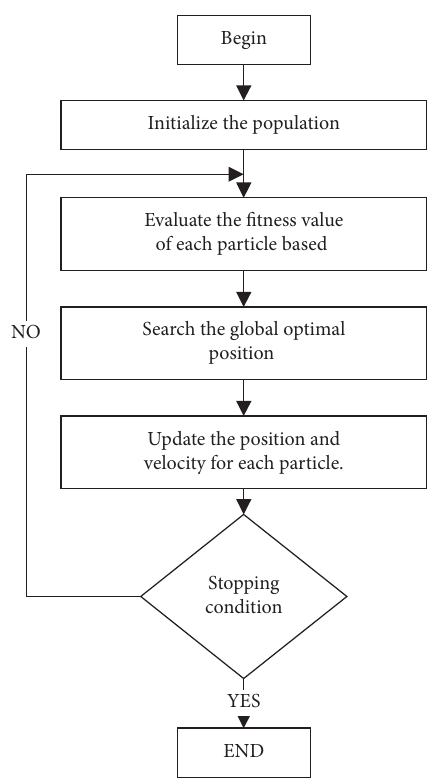
Figure 3: The particle swarm optimization for finding the best window length for